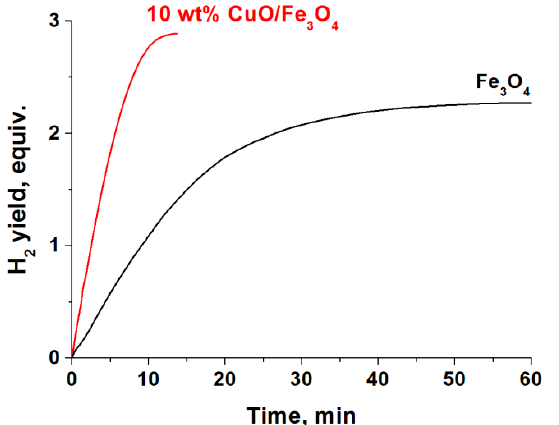
Figure 10. The change of activity of Fe 3 O 4 in the catalytic hydrolysis of NH 3 BH 3 (0.123 M) at 60 ◦ C upon its modification by CuO (10 wt%).